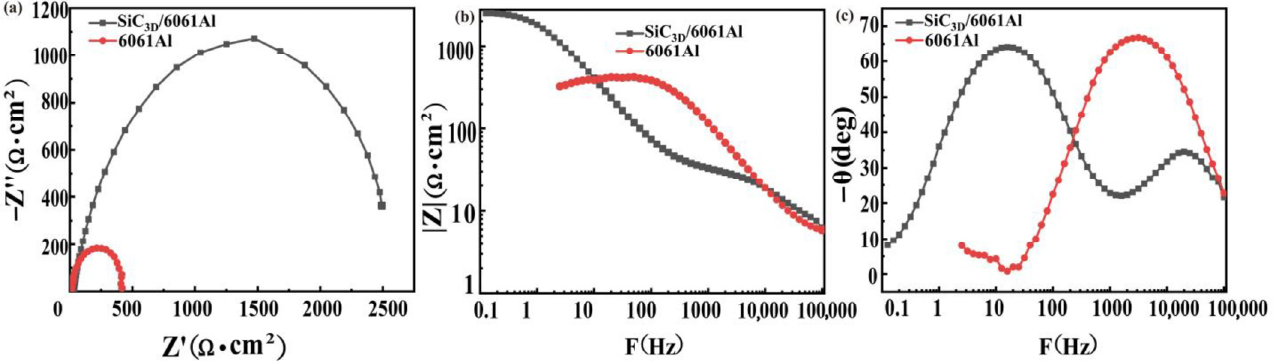
Figure 5. Uncorroded electrochemical alternating current impedance spectroscopy (EIS): ( a ) Nyquist diagram; ( b ) Bode diagram (|Z|-F); ( c ) Bode diagram ( −θ -F).